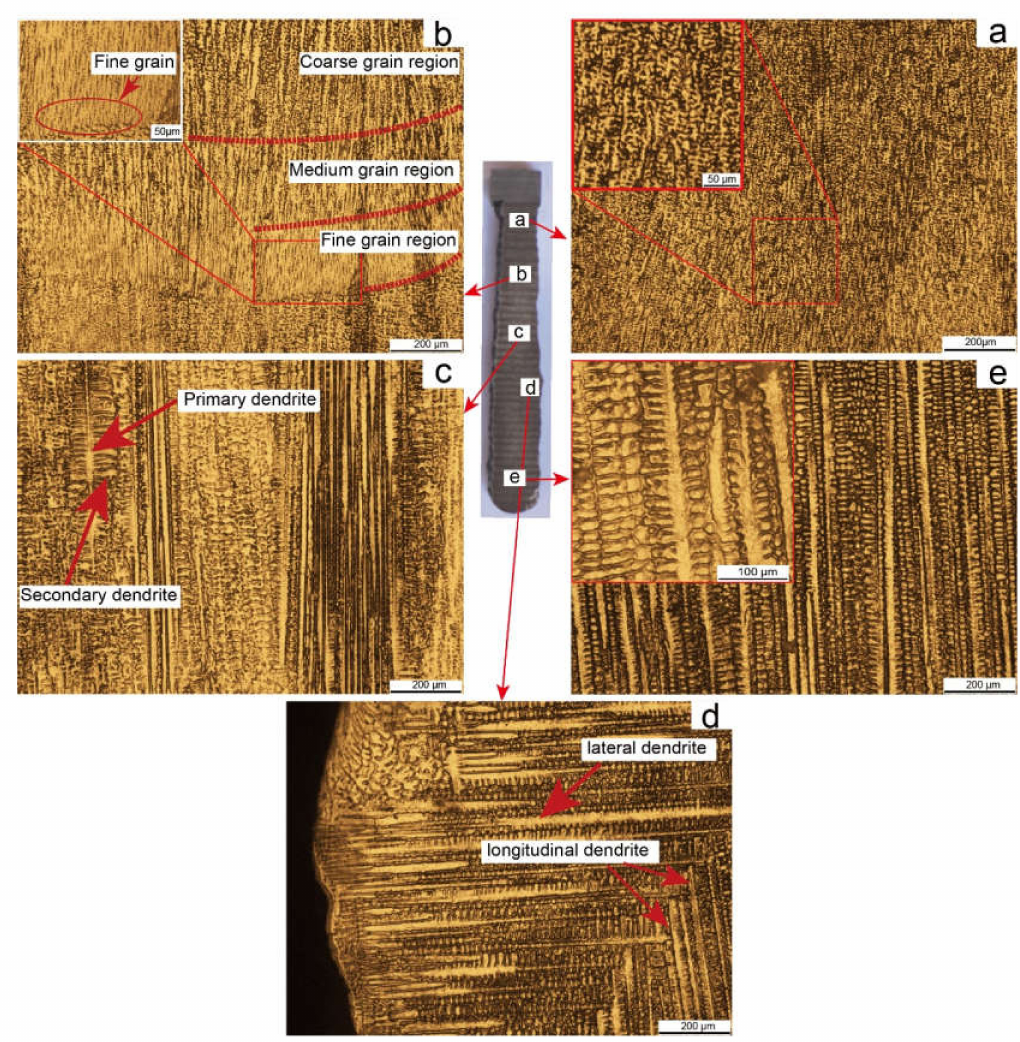
Figure 4. Microstructure of di ff erent regions of the sample #2: ( a ) bottom region, ( b ) lower region close to substrate, ( c ) middle region, ( d ) side wall region and ( e ) upper